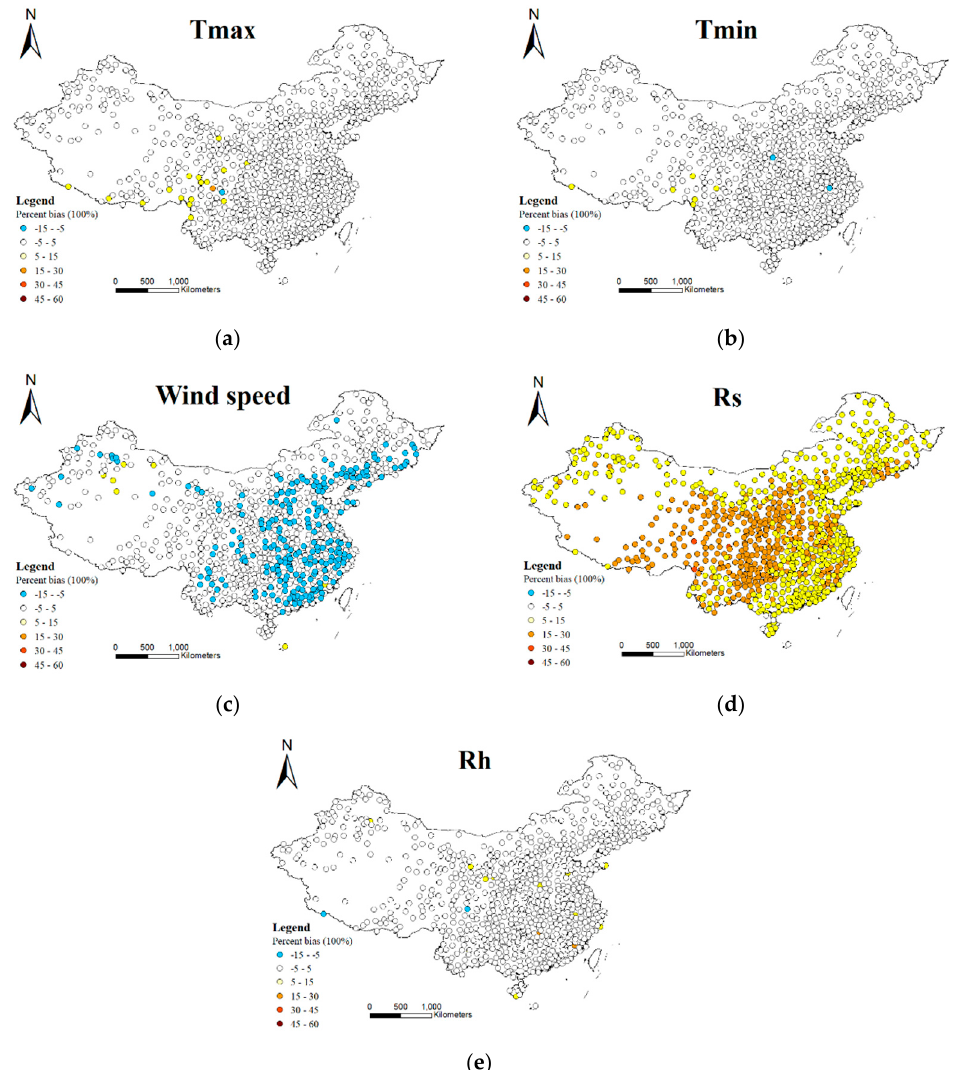
Figure 7. Spatial distribution of percentage bias showing the effects of maximum temperature ( a ), minimum temperature ( b ), wind speed ( c ), solar radiation ( d ), and relative humidity ( e ) on the bias of PET_cma.